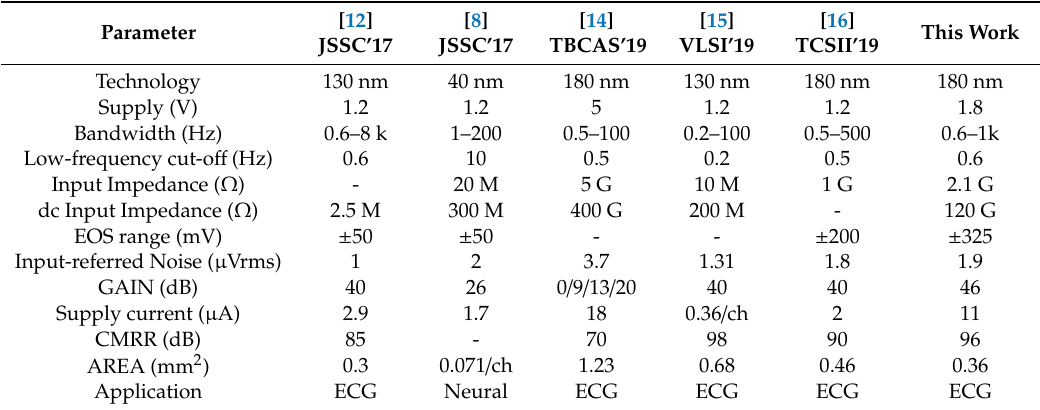
Table 1. Performance Comparison and